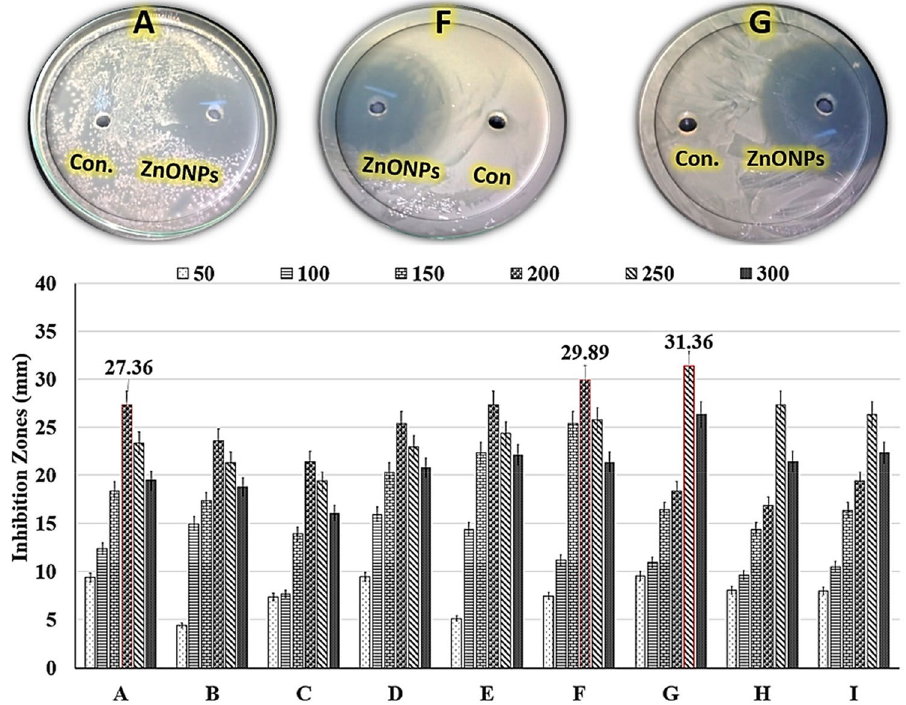
Figure 9. Antimicrobial activities of different doses of the controllable biosynthetic ZnO NPs (50, 100, 150, 200, 250, and 300 µg/mL) against some multi-drug resistant human pathogens, including: ( A ) Escherichia coli ; ( B ) Klebsiella pneumoniae ; ( C ) Pseudomonas aeruginosa ; ( D ) Staphylococcus aureus ; ( E ) Salmonella typhimurium , ( F ) Streptococcus pneumoniae , ( G ) Candida albicans , ( H ) Candida krusei ; ( I ) Candida tropicals ; and (con = control): endophytic Streptomyces albus E56 cell-free mixed cell-free